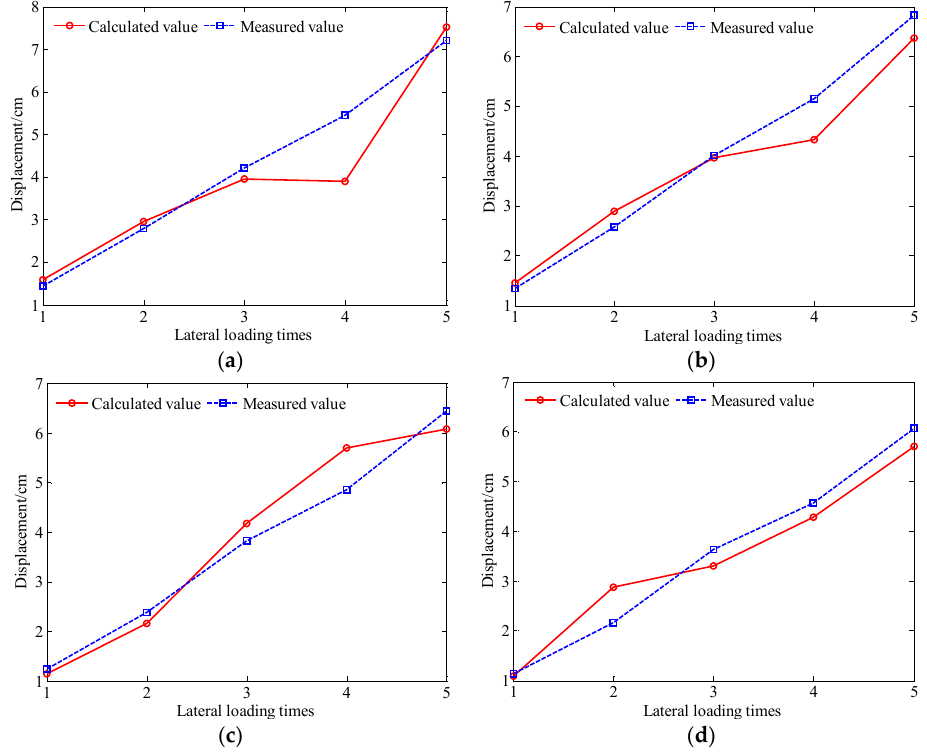
Figure 14. Calculated and measured deep displacement of a slope under different lateral loading times: ( a ) rod-fiber coupling structure I; ( b ) rod-fiber coupling structure Ⅱ ; ( c ) rod-fiber coupling structure Ш ; ( d ) rod-fiber coupling structure IV.